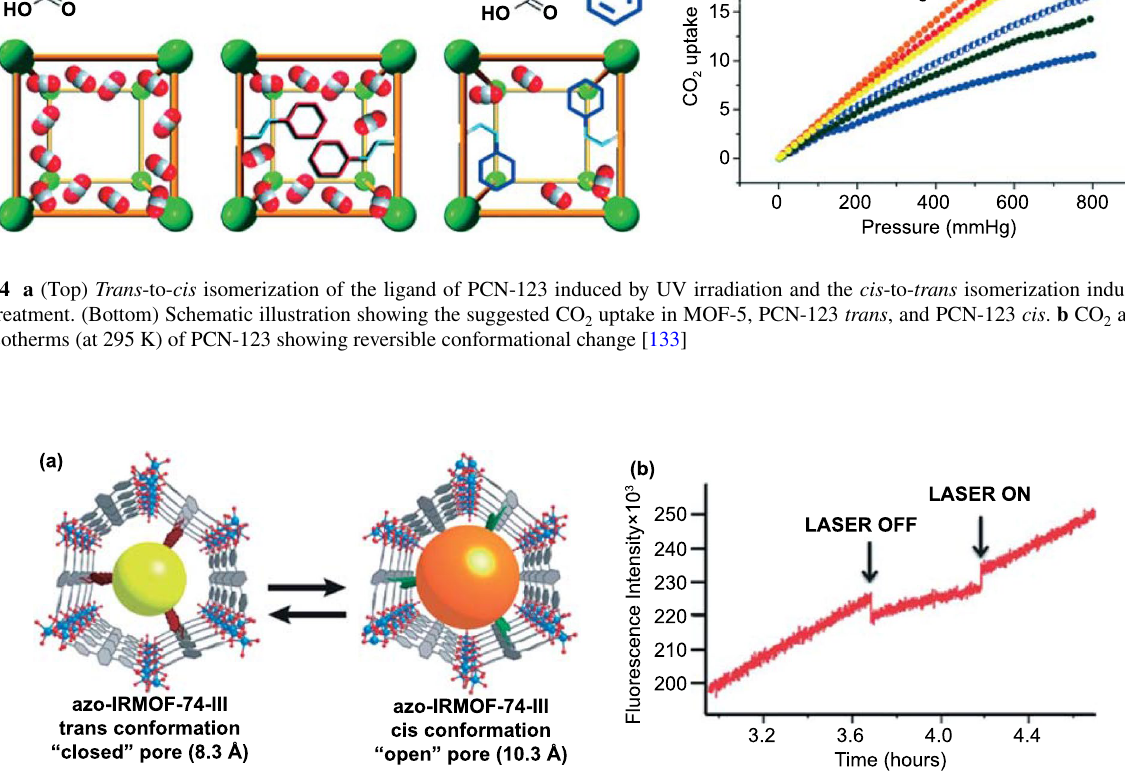
Fig. 15 a View of the idealized azo-IRMOF-74-III down the c-axis displays one-dimensional pores and azobenzene functional groups project- ing into the pores. The yellow and orange balls represent pore aperture in idealized Azo-IRMOF-74-III, when the azobenzene functional groups are in trans and cis conformation, respectively. b An on/off trial, where the excitation beam was temporarily removed mid-release